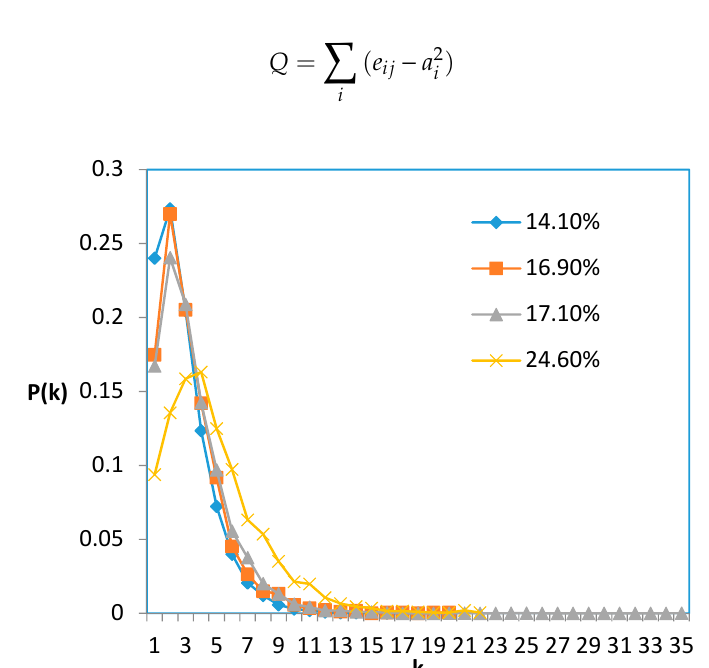
Figure 2. Degree distribution of sandstone three-dimensional pore network.